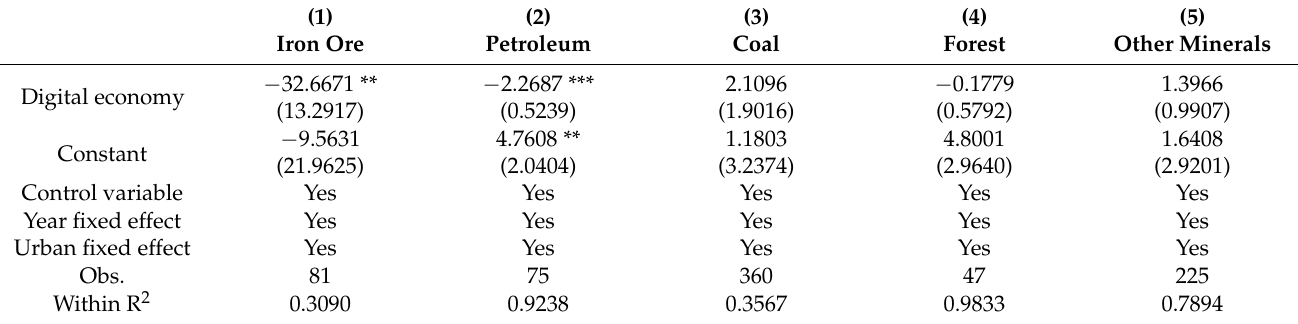
Table 12. Regression results of samples of resource-based cities dominated by different